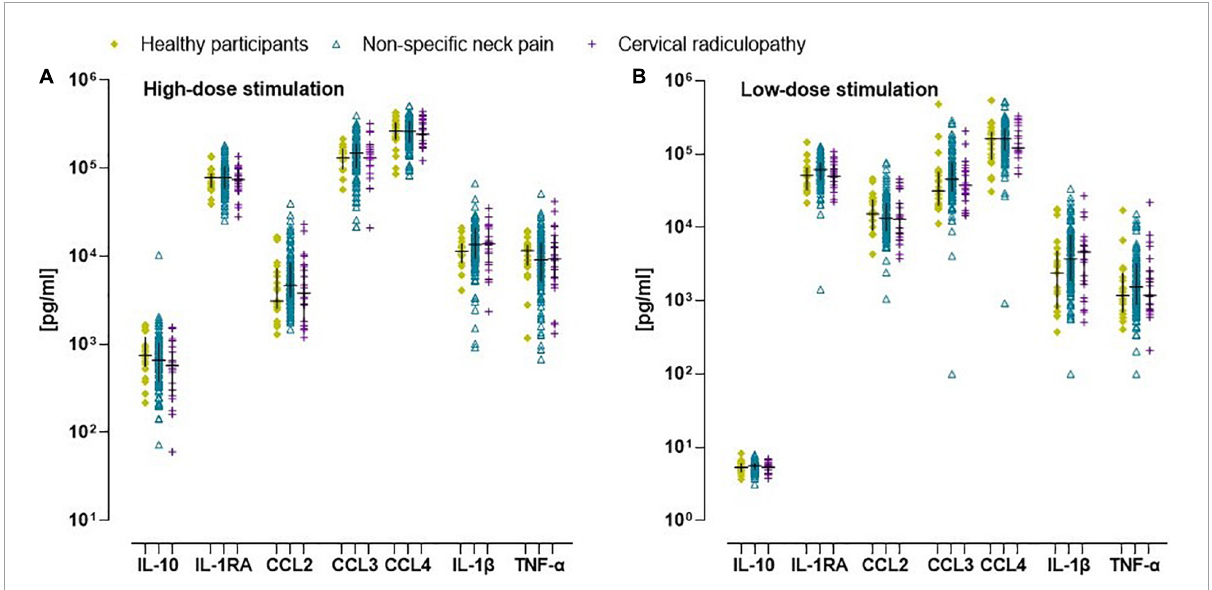
FIGURE3 Scatter plot and median (inter quartile range) of in vitro concentration of inflammatory markers in healthy participants, people with non-specific neck pain, and cervical radiculopathy. (A) Crude in vitro inflammatory marker concentration after whole blood stimulation with TLR4 agonist lipopolysaccharide at a concentration of 10 µ g/ml (high dose-LPS stimulation) in healthy participants, people with non-specific neck pain, and cervical radiculopathy. (B) The raw in vitro inflammatory marker concentration after whole blood stimulation with TLR4 agonist lipopolysaccharide at a concentration of 1 ng/ml (low dose-LPS stimulation) in healthy participants, people with non-specific neck pain, and cervical radiculopathy. To determine significant differences between groups the in vitro values were first Ln-transformed and finally expressed/1,000 monocytes. Lines represent median ( horizontal line ), and 25th–75th percentiles. TNF- α , tumor necrosis factor- α ; IL-1 β , interleukin-1 β ; IL-1RA, interleukin-receptor antagonist; IL-4, interleukin-4; IL-10, interleukin-10; CCL2, c-c-motif ligand 2 also referred to as monocyte chemoattractant protein 1; CCL3, c-c-motif ligand 3 also referred to as macrophage inflammatory protein 1 α ; CCL4, c-c-motif ligand 4 also referred to as macrophage inflammatory protein 1 β . The scatter plot was based on the individual points of 112 people with non-specific neck pain, 25 with cervical radiculopathy and 23 healthy